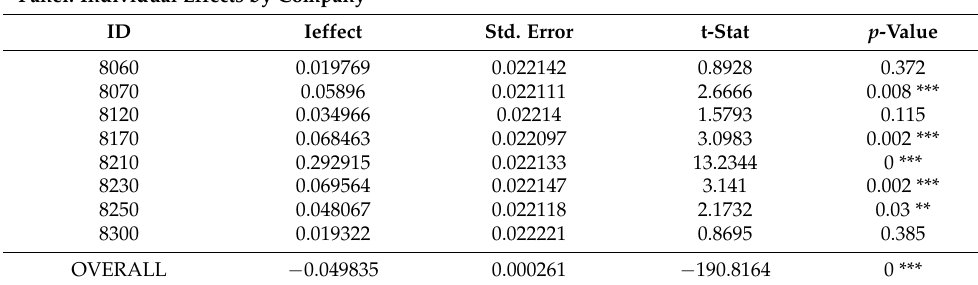
Table A2. Cont. Panel: Individual Effects by